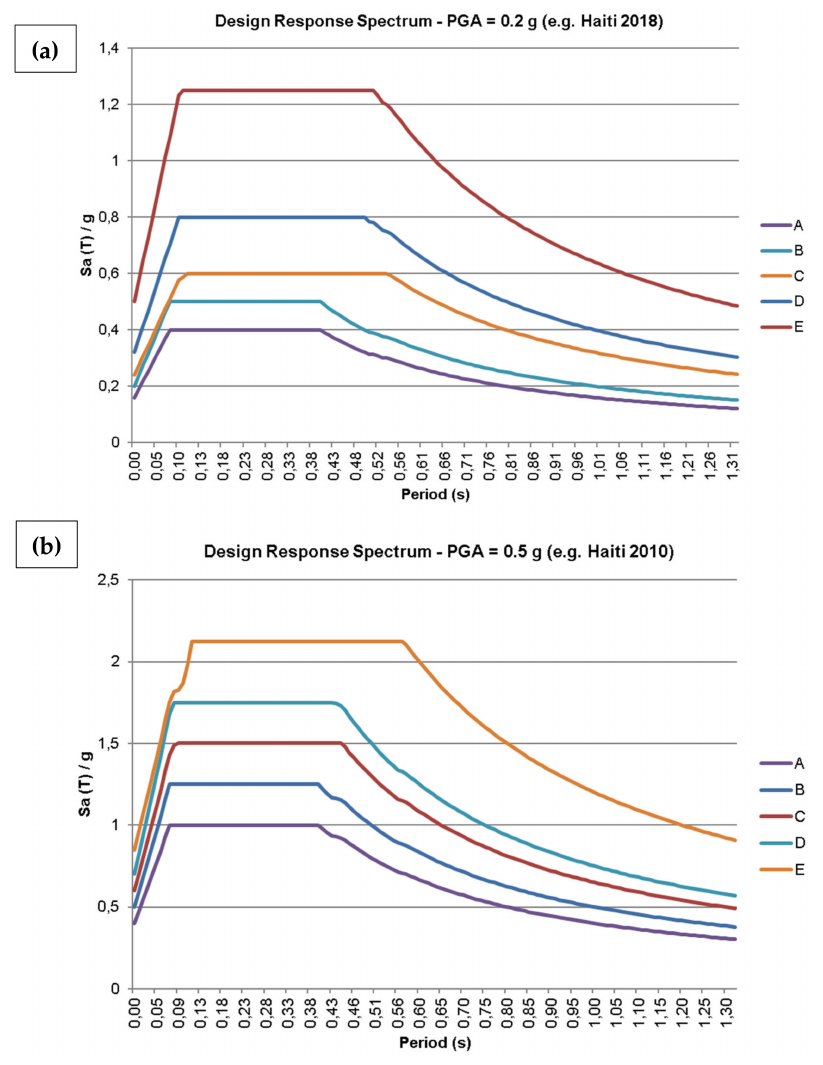
Figure 18. ( a ) Design response spectrum for PGA = 0.2 g (e.g., Haiti, 2018); ( b ) Design response spectrum for PGA = 0.5 g (e.g., Haiti, 2010)